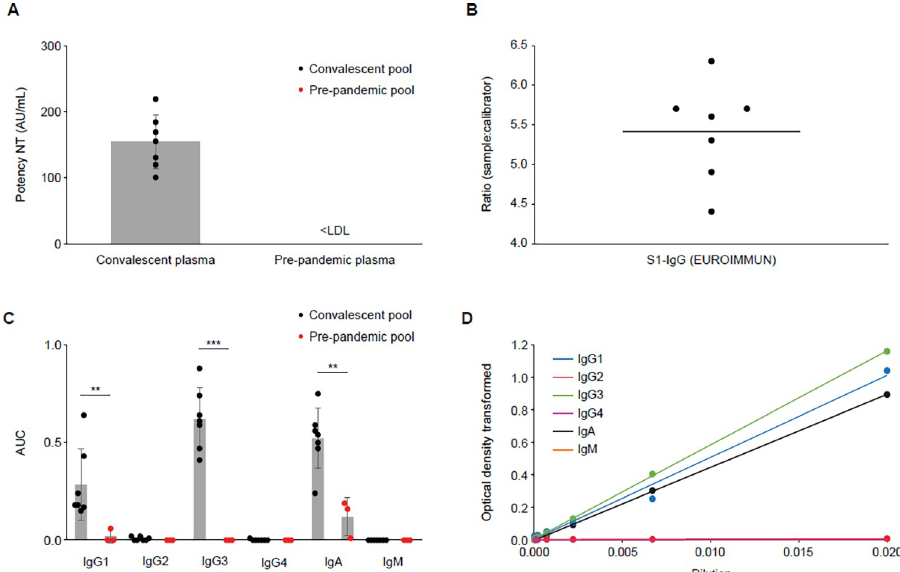
Fig 2. Serological characterization of investigated plasma pools. (A) Neutralization titer of convalescent (n = 7) and pre-pandemic (n = 3) plasma pools. Data are shown as mean ± SD. (B) EUROIMMUN testing results (S1-IgG ELISA) for convalescent plasma pools (n = 7). (C) Ig classes of convalescent and pre-pandemic plasma pools against S1 ELISA (modified EUROIMMUN ELISA). Data are shown as mean ± SD. Asterisks indicate the level of statistical